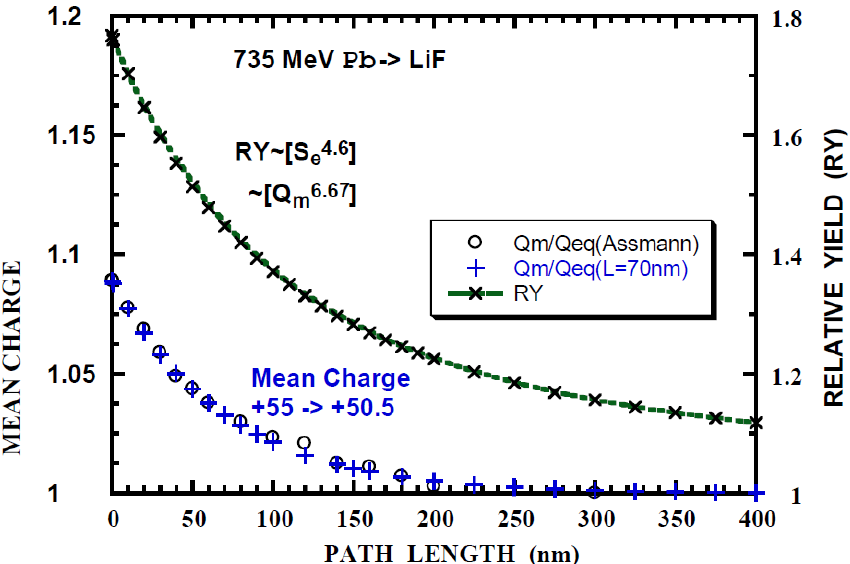
Figure 9. Relative yield (RY) of the electronic sputtering of LiF by 735 MeV Pb +55 (x) calculated with n = 4.6, S e = 0.098Q 1.45 as a function of path length. Open circles (o) is the mean-charge evolu- tion from [36] normalized to the equilibrium-charge Q eq = 50.5 and saturation approximation (+) (Equation (2a)) with L = 8 nm and Q o = 55. Integrand for RY is indicated by [ ].